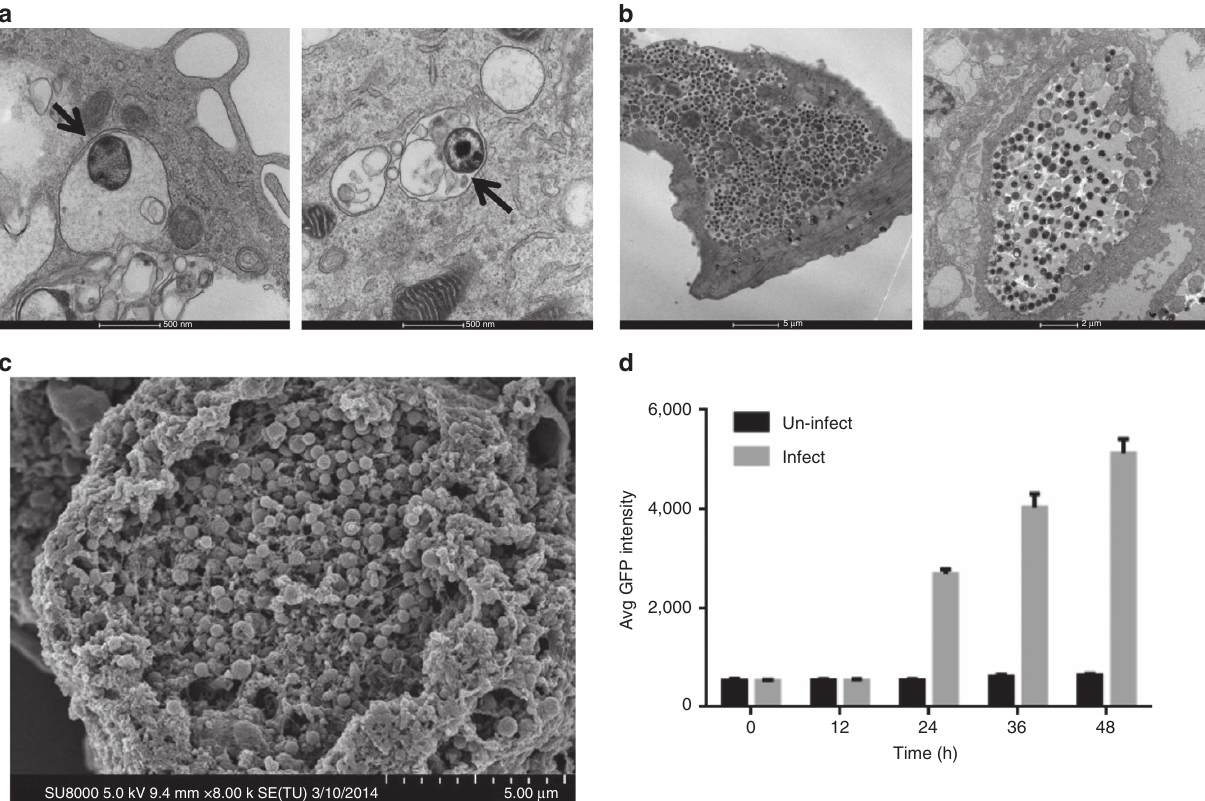
Figure 2 | Imaging of human iPSdMs infected with C. trachomatis. ( a ) Representative transmission electron microscopy (TEM) image of iPSdM (left) and blood monocyte-derived macrophage (right) infected for 1h (arrows indicating Chlamydia- containing inclusions formed inside infected macrophages), ( b ) representative TEM image of iPSdM (left) and blood monocyte-derived macrophage (right) infected for 24h. ( c ) Representative scanning electron microscopy image of iPSdM infected for 48h. ( d ) Changes in GFP intensity during a 48h infection of iPSdMs with GFP-tagged C. trachomatis . Results are the average of three independent measurements ± s.d. using the Incucyte imaging system.